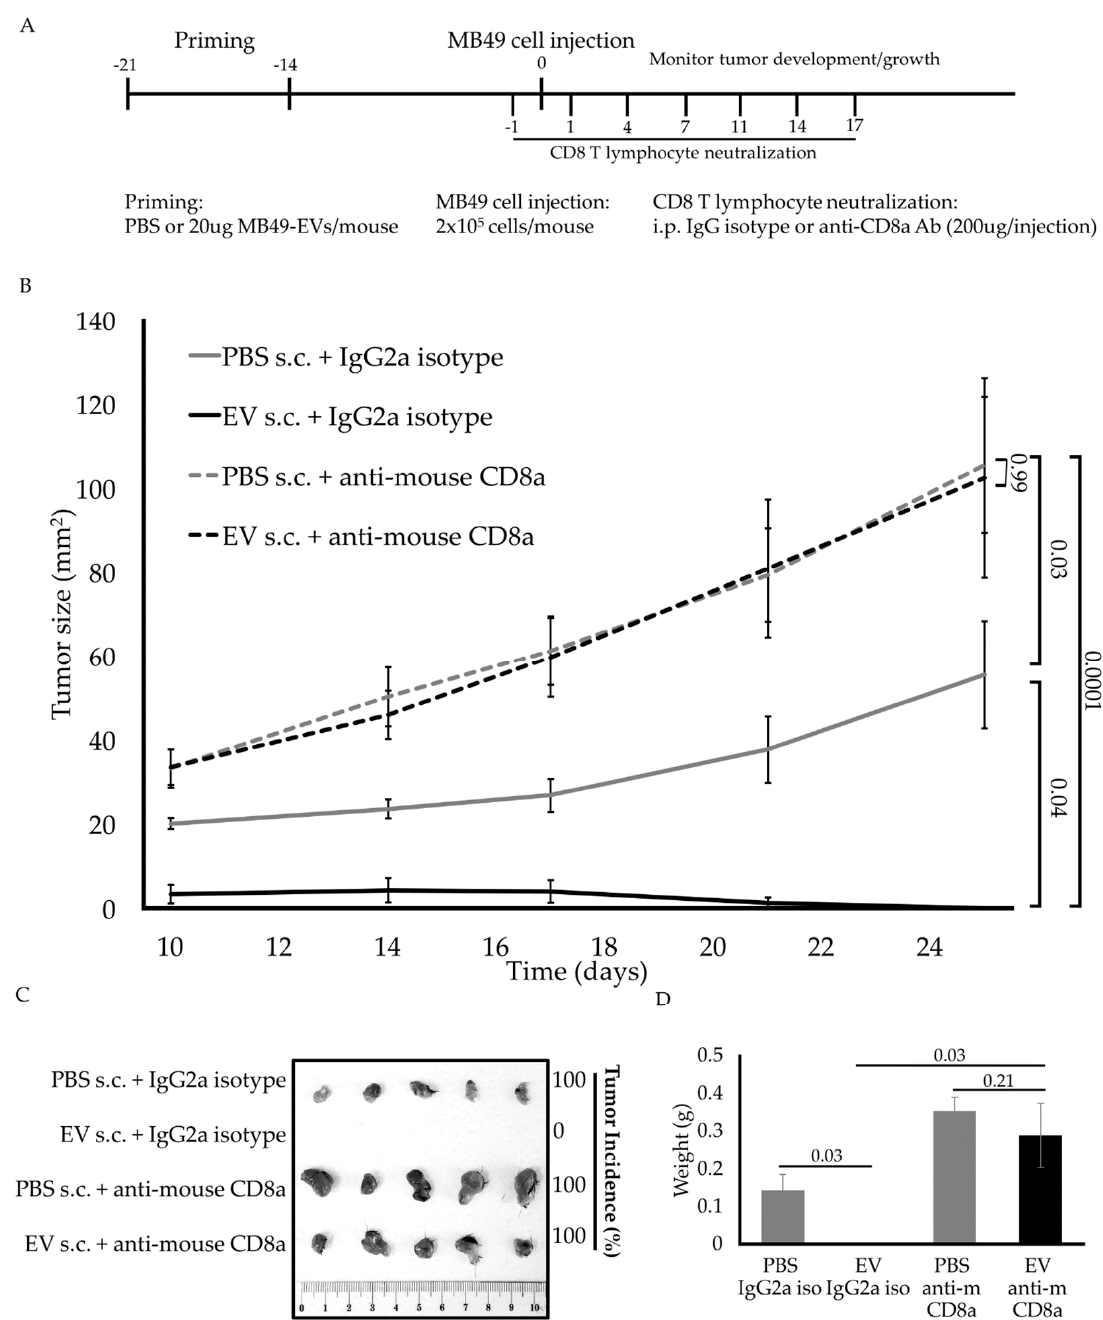
Figure 4. CD8 + T cells mediate the MB49 EV-driven antitumor immune response. ( A ) Diagram of in vivo experimental design timeline. ( B ) Subcutaneous MB49 tumor growth curve (mm 2 ) showing the average tumor size for each treatment group. ( C ) Images of harvested MB49 tumor tissue after 25 days of in vivo growth. Tumor incidence percentages are shown on the right. ( D ) Bar graph showing the averaged tumor weight for each treatment group at day 25. The n number is 5 on each group. Error bars show standard error. Statistical significance was calculated by two-way ANOVA with Tukey’s multiple comparisons